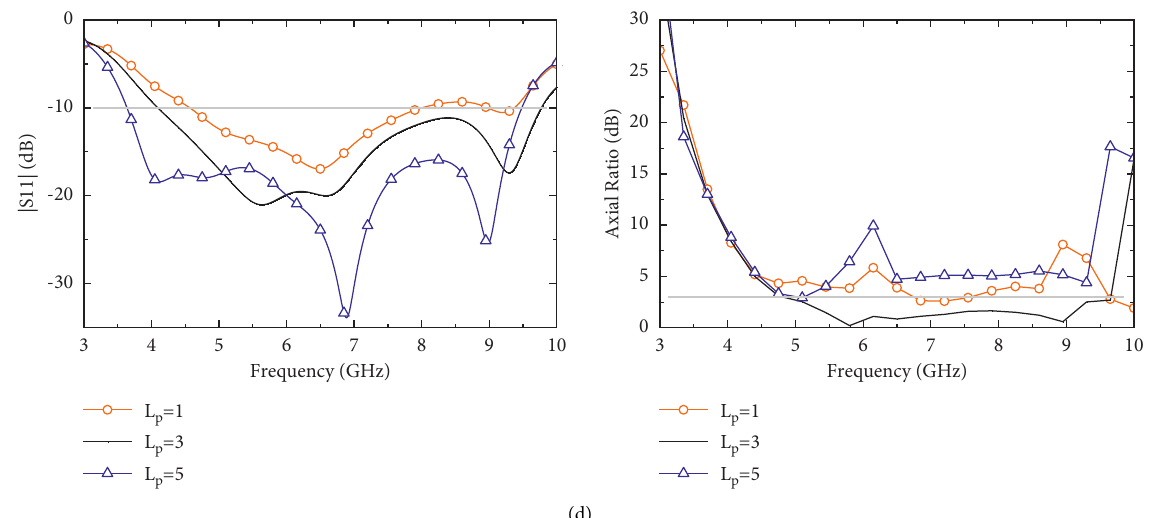
Figure 8: Simulated |S11| and AR of the proposed antenna for parametric analysis with different (a) W